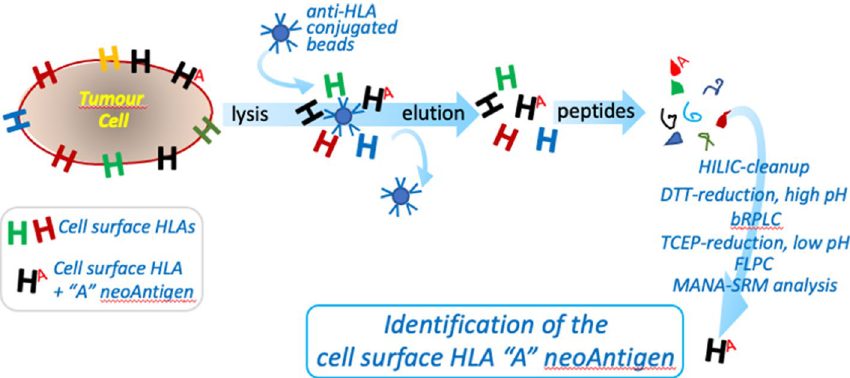
Fig. 2 Purification and identification of the cell surface HLA"A" neo-antigen against p53 R175H. The Mutation-Associated Neoantigen— Selected Reaction Monitoring (MANA-SRM) pipeline starts by lysing the cells, and enriching HLA-bound peptides through immuno-precipi- tation with an antibldy targeting HLA molecules. HLA molecules together with their presented peptides are then eluted and dissociated. At this stage, the eluate containing the neo-antigenic peptides is filtred for lower molecular weights using a cut off of 3 kDa and the samples are lyophilized and analyzed for MANA-SRM using an improved hydrophilic interaction liquid chromatography (HILIC) cleanup; reduction at different pH using DL-dithiothreitol (DTT) or tris(2-carboxyethyl)phosphine (TCEP) is used before analysing the optimization of collision energies and fractionation. Manually examination and curation to exclude ions with excessive noise due to coelution with impurities is required to detect heavy isotope-labeled neo-antigens. See the original reference for details (Wang et al. Cancer Immunol Res,